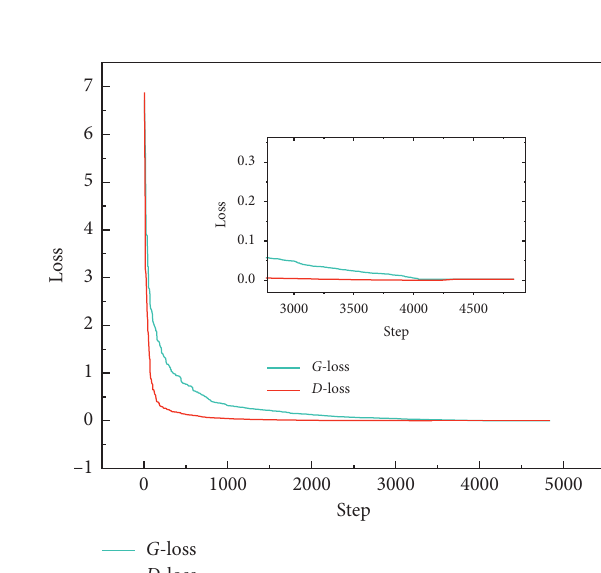
Figure 10: GAN dynamic architecture.